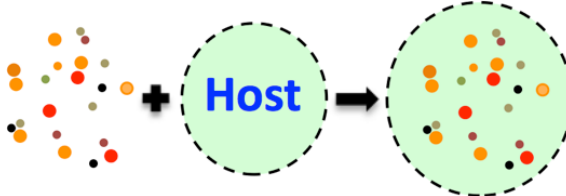
Figure 2. Illustrates the general logistics of an effective refractive index calculation using a conversion model that is based upon the Maxwell Garnett effective medium